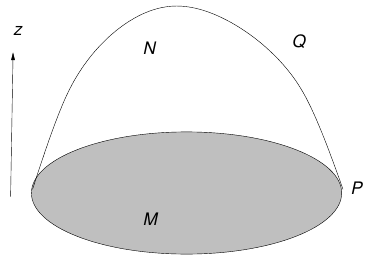
Figure 1 . BCFT on M and its dual N